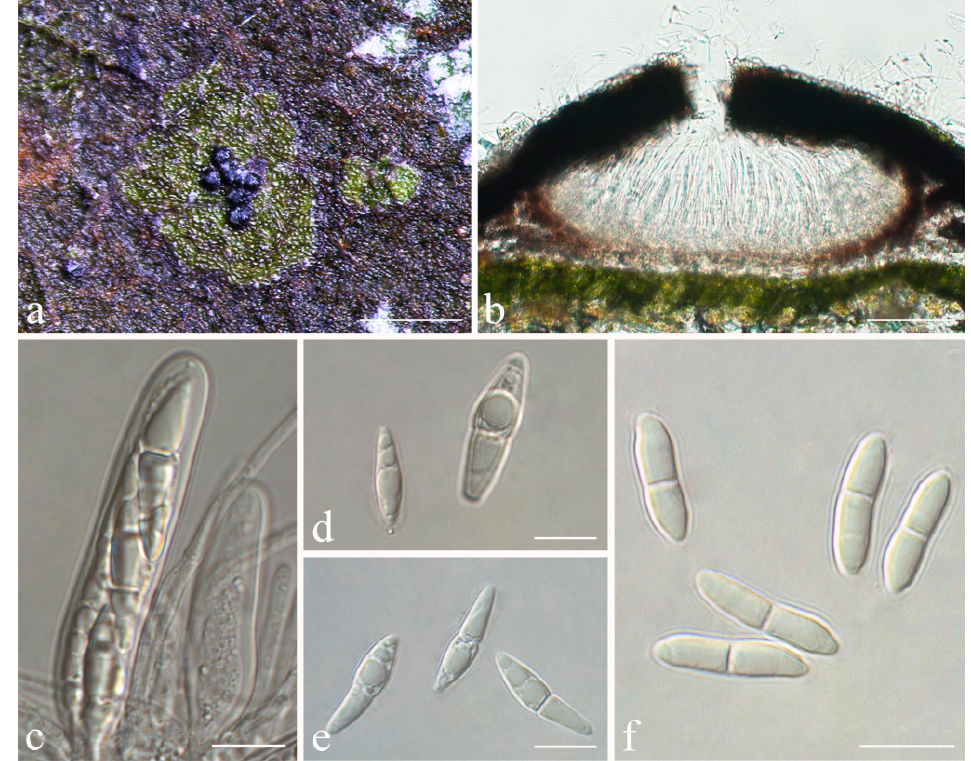
Figure 11. Strigula pseudoantillarum sp. nov. ( a ) Thallus with pycnidia (holotype, HMAS–L0137209); ( b ) perithecia (holotype, HMAS–L0137209); ( c ) ascus with biseriate ascospores (holotype, HMAS– L0137209); ( d ) ascospores (holotype, HMAS–L0137209); ( e ) ascospores (HMAS–L0137211); ( f ) macroconidia (HMAS–L0137211). Scale bars: ( a ) = 200 μ m, ( b ) = 50 μ m, ( c – f ) = 10 μ m.